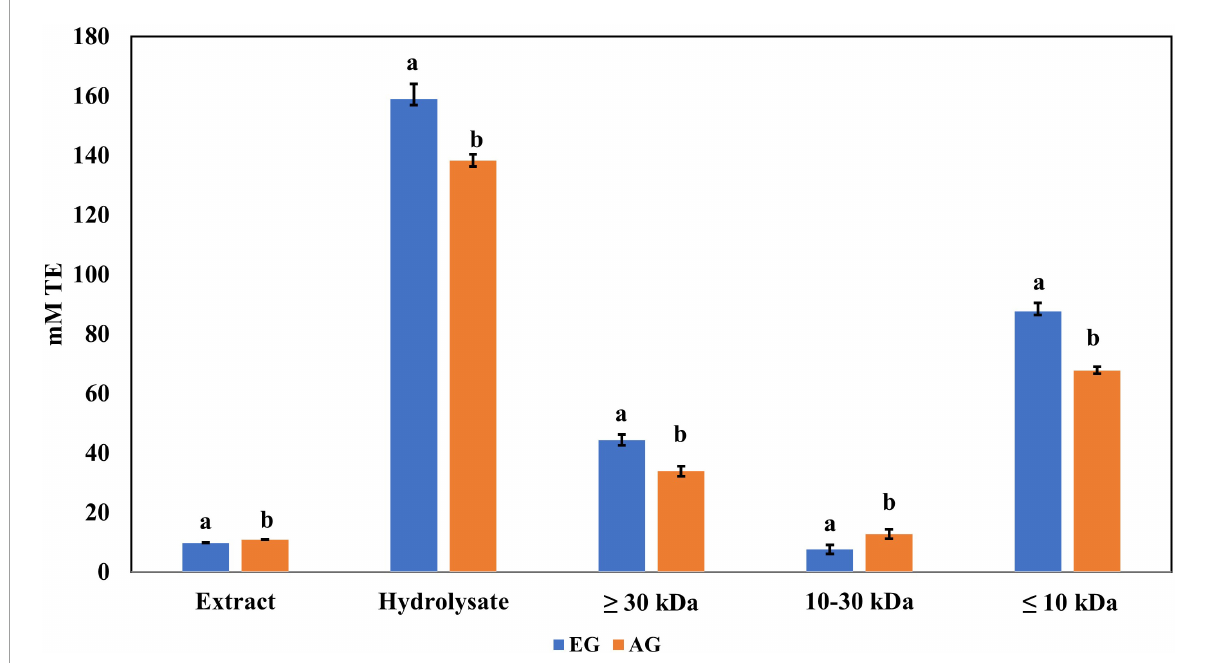
FIGURE2 Antioxidant activity against 2,2-diphenyl-1-picrylhydrazyl (DPPH) radical of extracts, hydrolysates, and hydrolyzed fractions of early grasshopper (EG) and adult grasshopper (AG). Results are expressed in millimolar trolox equivalents (mM TE)/gram dry weight. Different letters between bars indicate a significant difference ( p -value <